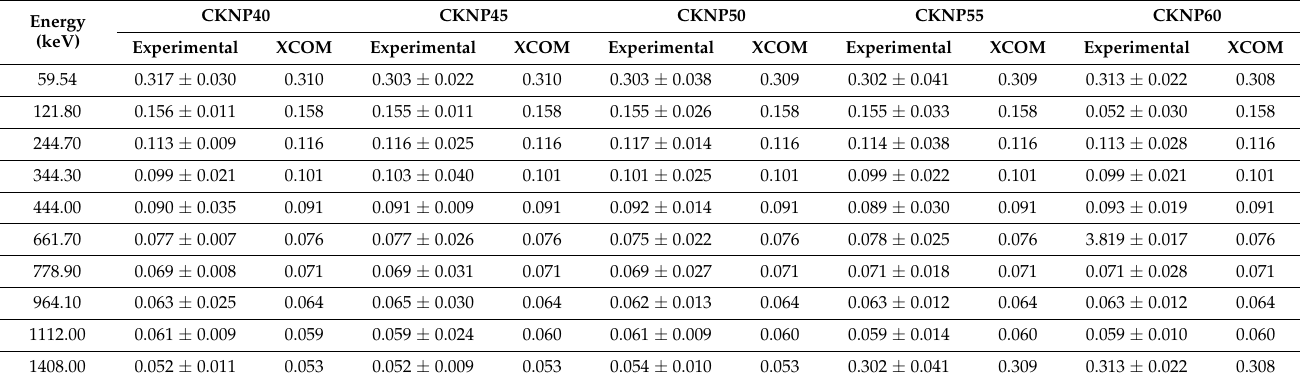
Table 1. The measured mass attenuation coefficient and XCOM results for the fabricated